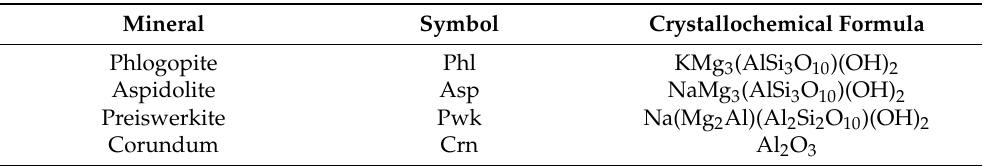
Table 3. Theoretical compositions of minerals (solid-solution components) adopted for calculating chemical reaction equations.